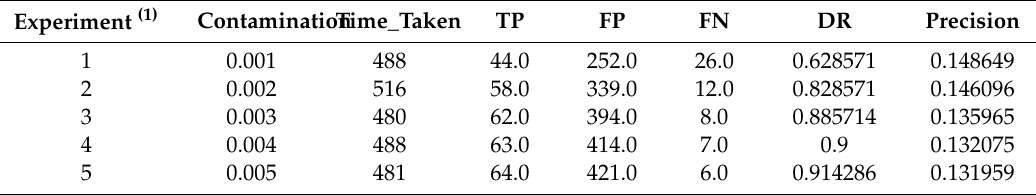
Table 8. LOF results for subset of four (4) features.